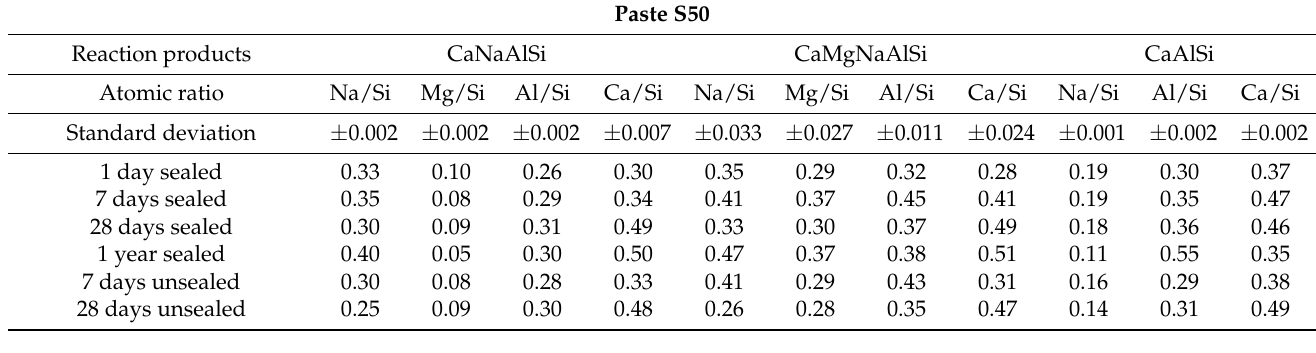
Table 7. Atomic ratios in the reaction products by PARC analysis in paste S50.